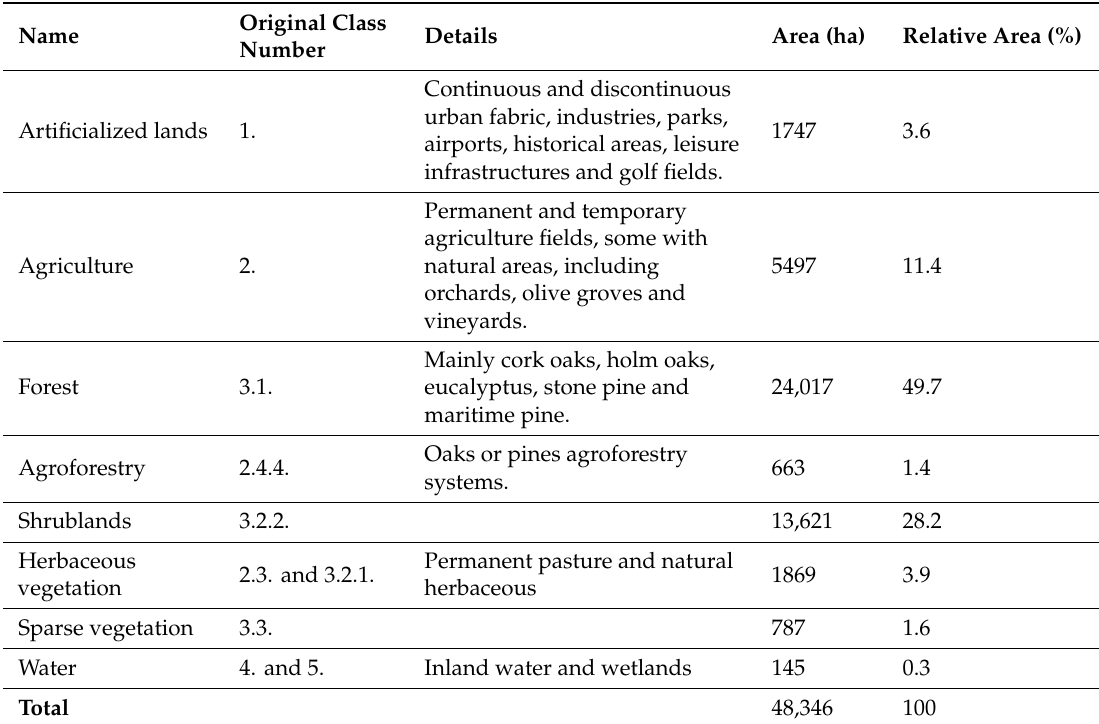
Table 1. Simplified land cover classification, adapted from [22], with area and relative area in the Portuguese fuel break